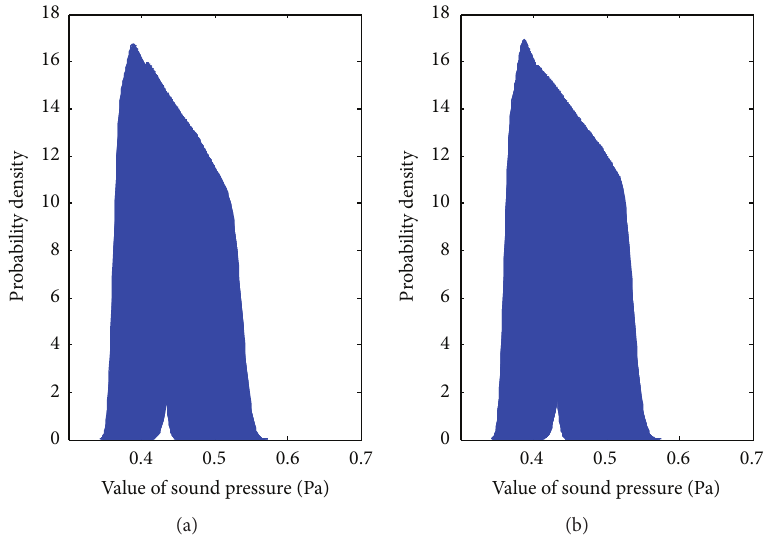
Figure 5: The lower and upper bounds of the response probability density of node 𝑅2 calculated by (a) MCS and (b) PCRS.